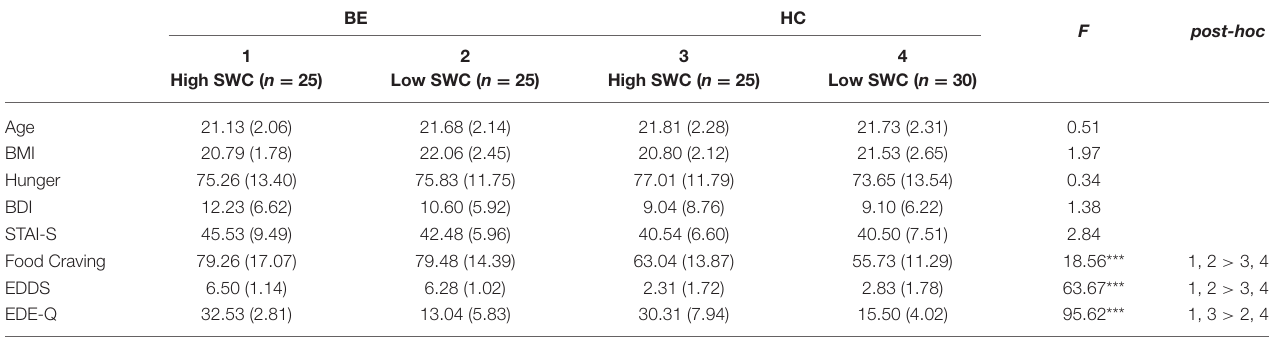
TABLE 1 | Demographics and clinical characteristics for each group.